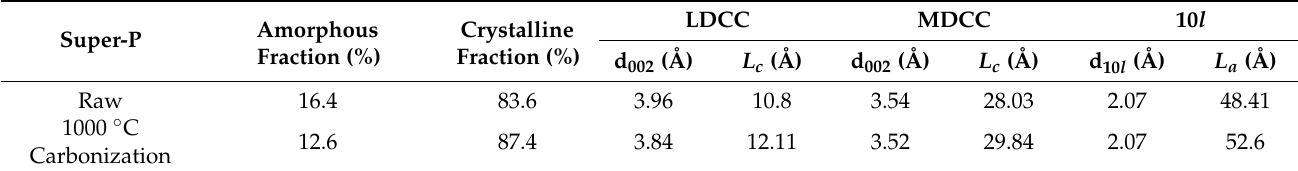
Table 4. Structural parameters of carbon black carbonized at 1000 ◦ C obtained from